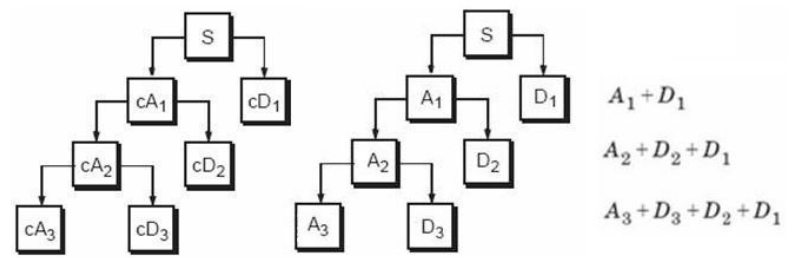
Figure 1. Signal decomposition in approximations and details ( left ) and its re-composition ( right ).